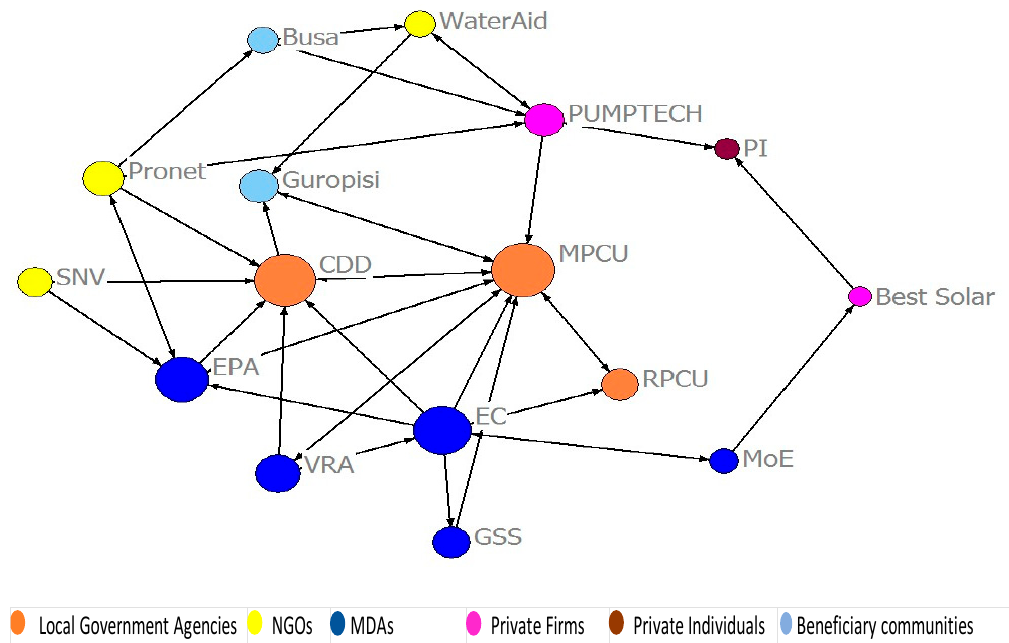
Figure 4. The eigenvector centralities of actors in the network (Source: Authors’ conception, created with the NETDRAW component of UCINET 6 [49].